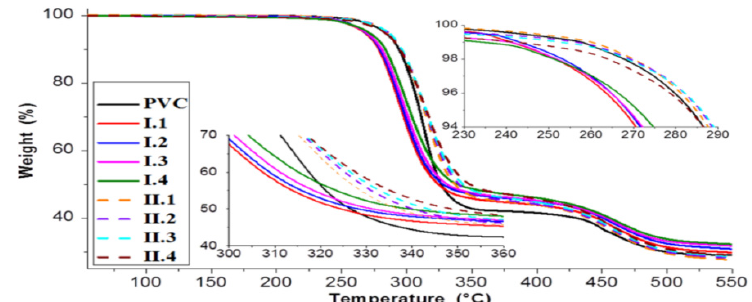
Figure 11. TGA of PVC and PVC composites.